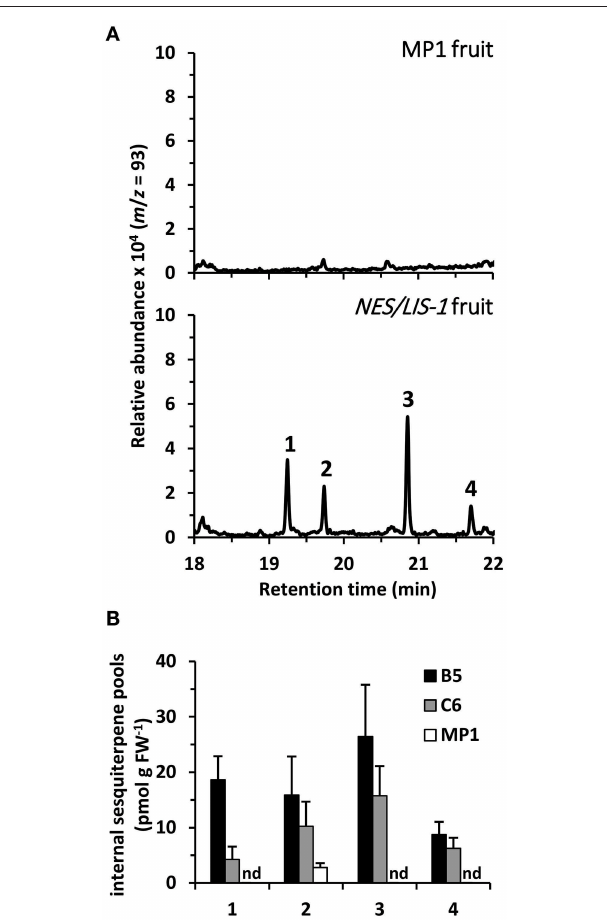
FIGURE 4 | Metabolic profiling of internal sesquiterpene pools in AmNES/LIS-1 fruits. (A) Terpenes were directly extracted from ripe fruits of MP1 control and AmNES/LIS-1 transgenic tomato (line B5). Extracts were analyzed by GC-MS and traces obtained for m/z = 93 (characteristic for terpenes) are shown. Based on their mass spectra and retention time the following compounds were identified: 1, nerolidol; 2, unknown 1; 3, unknown 2; 4, nerolidyl acetate. (B) Quantitative analysis of nerolidol and its derivatives extracted from fruits of the AmNES/LIS-1 lines B5 and C6, and the MP1 control. Data are means ± SEM ( n ≥ 3). FW, fresh weight; nd, not detected.